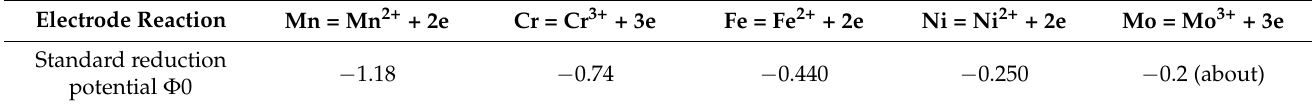
Table 4. Standard reduction potential of main metals Φ 0 (v, vs, SHE-Standard hydrogen electrode), 25 ◦ C. Electrode Reaction